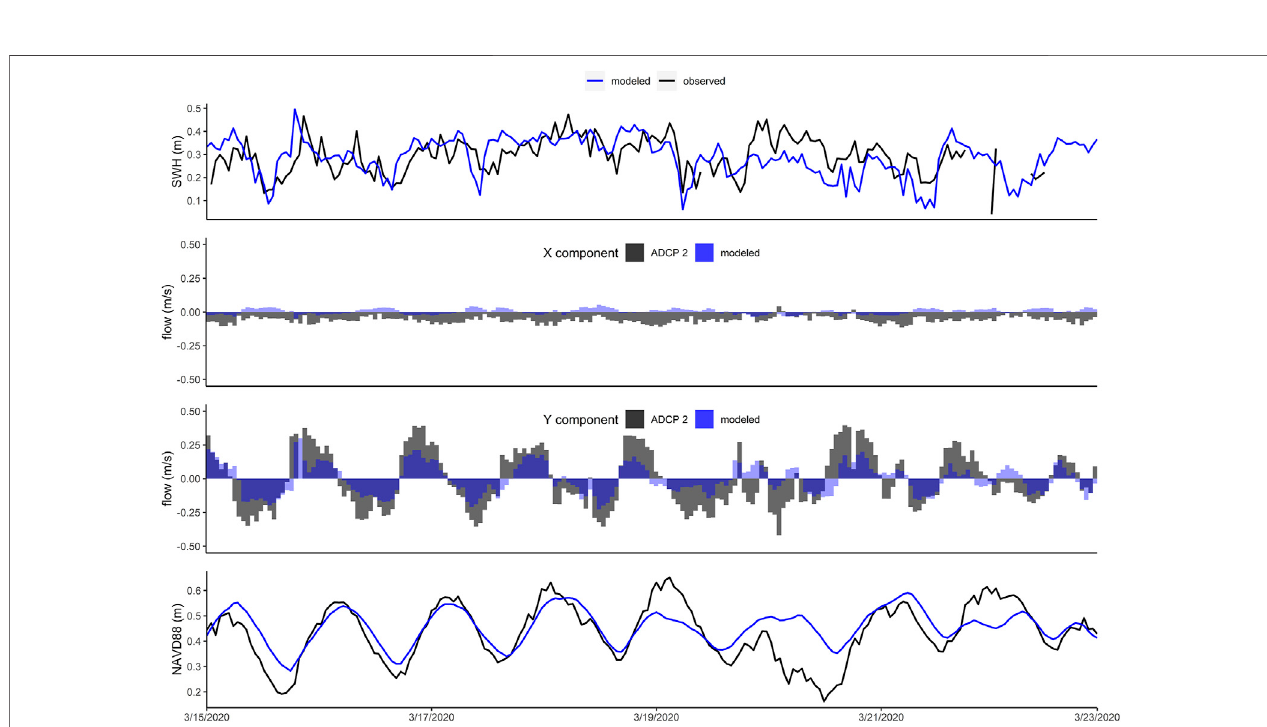
Frontiers in Built Environment |